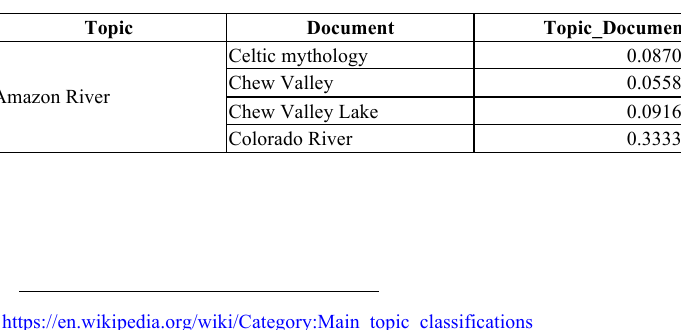
Table 1. Sample entry in the inverted topic